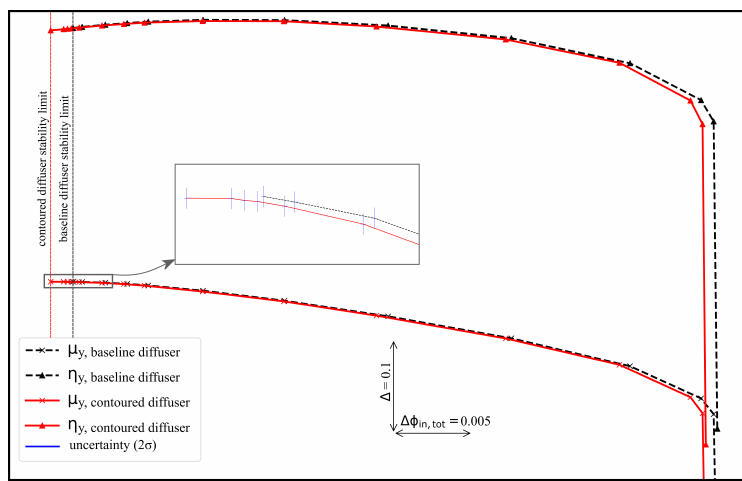
Figure 7. Performance characteristics at stage Mach number Mu 2 =